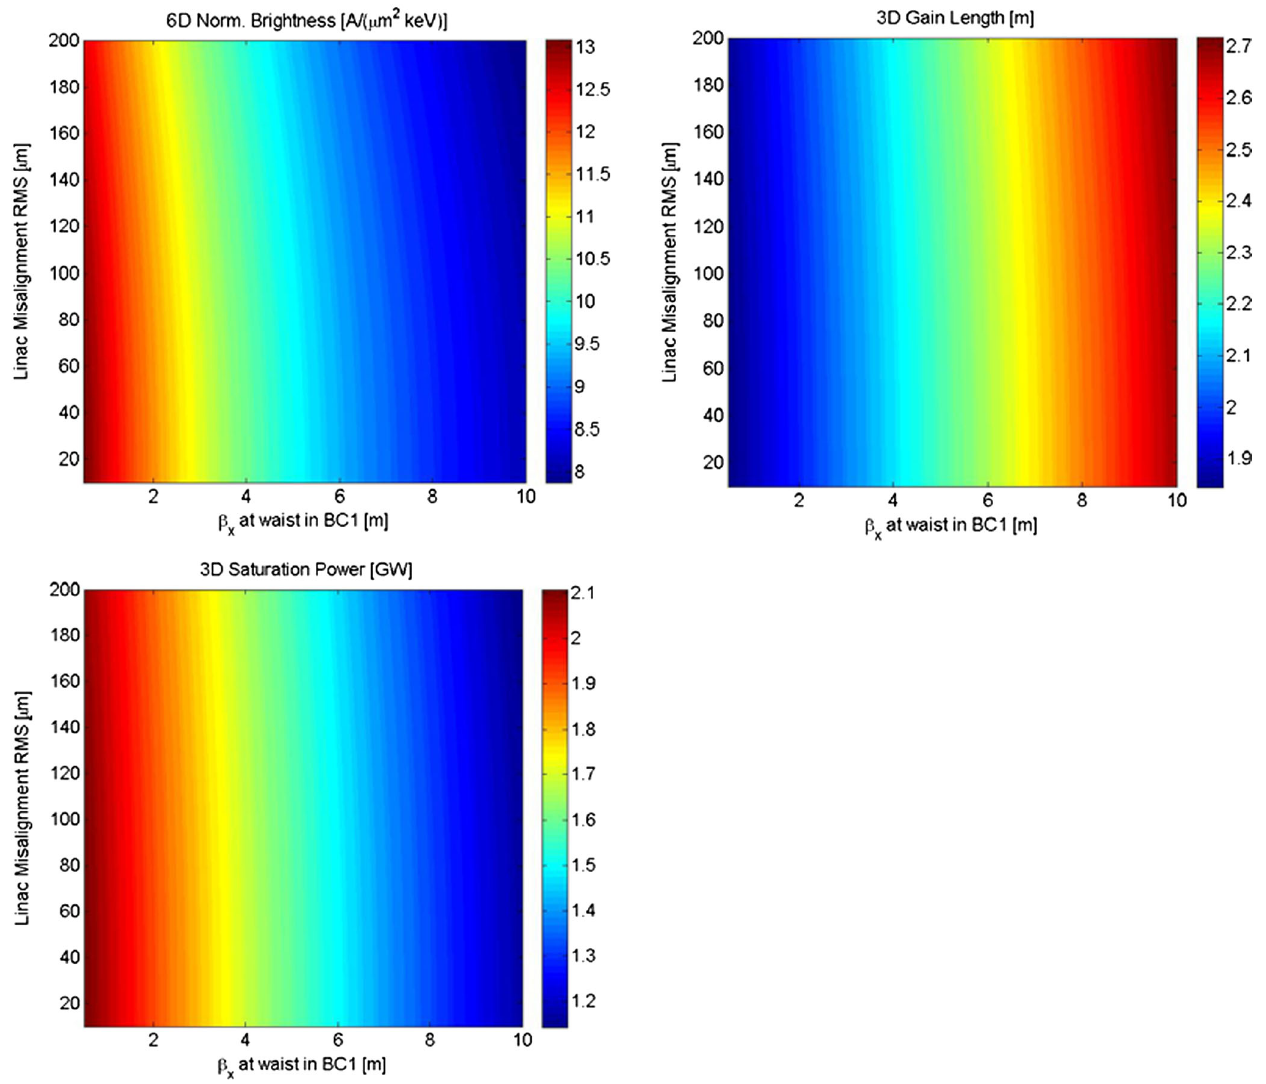
FIG. 11. Contour plot of B (top left), L (top right), and P as a function of the rms linac-to-beam misalignment and the n; 6 D g; coll sat ; coll minimum betatron function in BC 1 , for a 50 pC bunch charge, compressed by a factor C ¼ 25 × 4 in the XL linac. The final peak current is 1